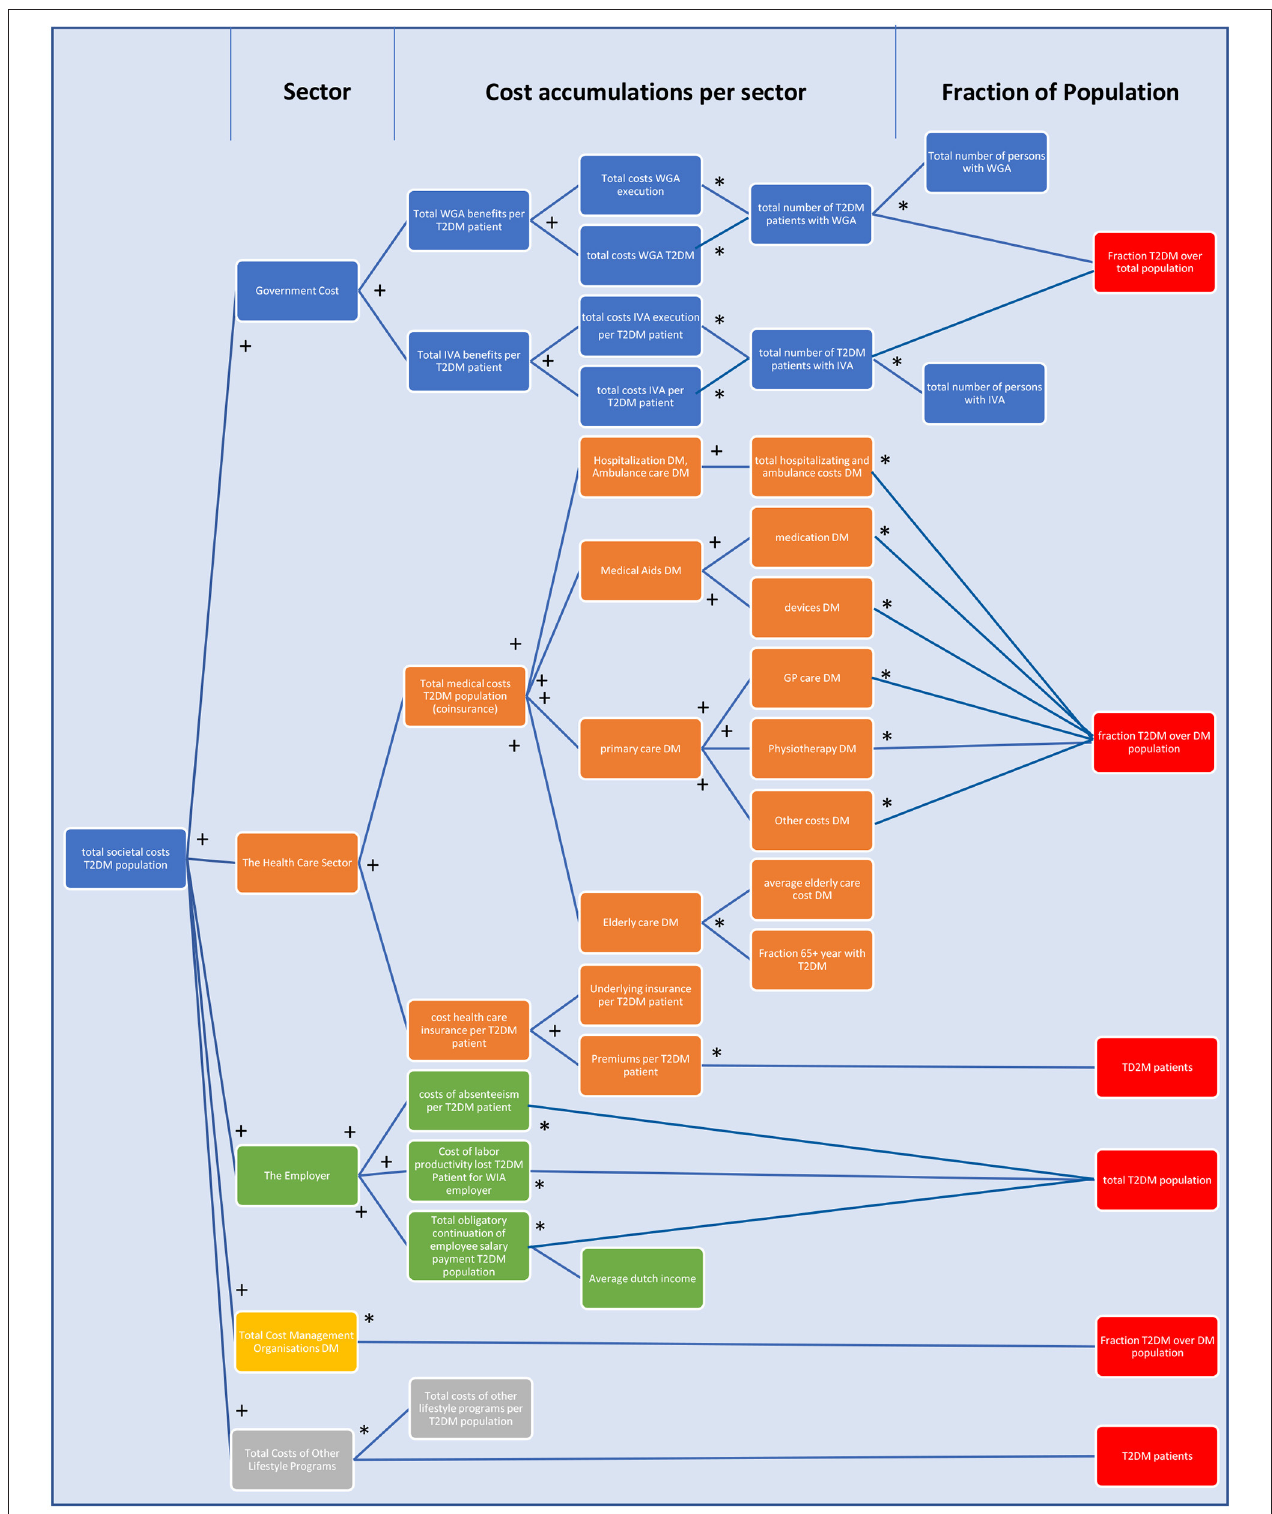
FIGURE 4 | A schematic overview of the total costs of T2DM in The Netherlands as incorporated in the model. The figure follows the logic: from the portion of the Dutch population that has T2DM, in whichever way that fits for the equation (red), multiple costs to society are calculated via multiplications (*) and cumulations ( + ). Blue = costs for Dutch authorities, orange = costs for the financial health care sector, green = costs for the employer, yellow = total costs for management of DM, and gray = total costs of other lifestyle programs. For details of WGA, WIA, and IVA, see section The Construction and Calculation of Total Cost Arising From T2DM (47).